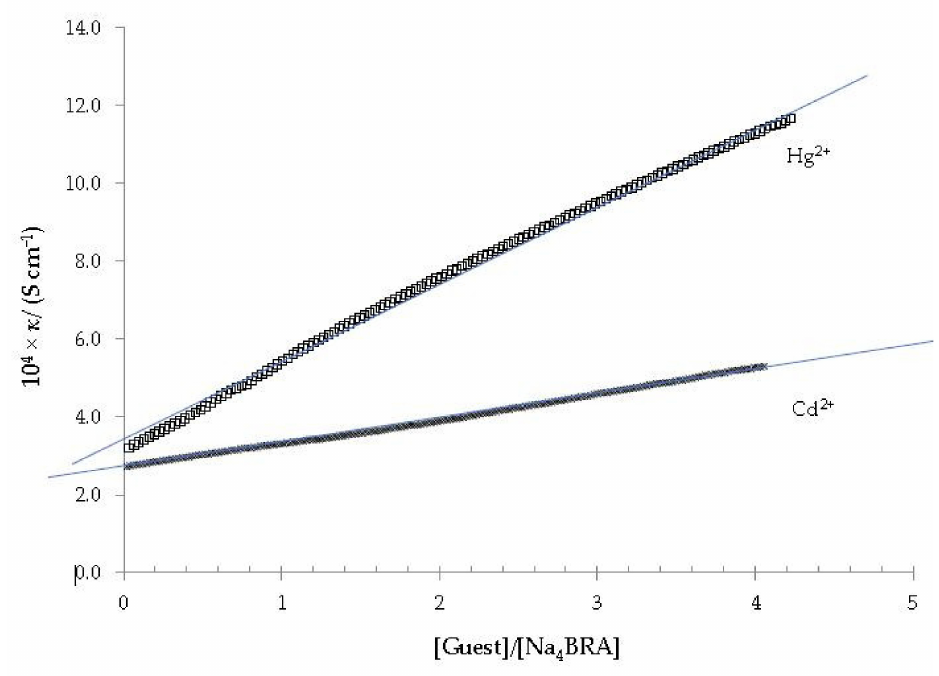
Figure 6. Specific conductivity versus the [Hg 2+ ]/[Na 4 BRA] and [Cd 2+ ]/[Na 4 BRA] ratios. The solid blue lines are displayed as a visual aid to see that there is no appreciable change in the slope of the